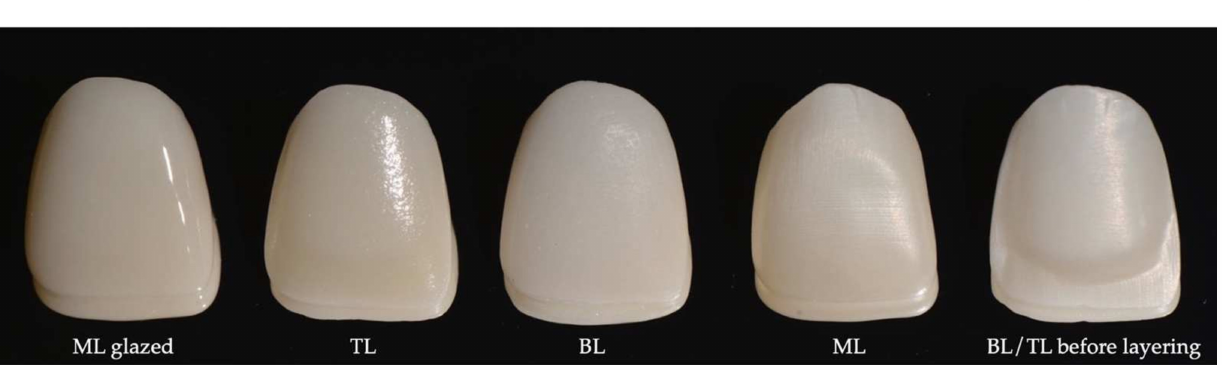
Figure 2. The appearance of the restorations in different fabrication